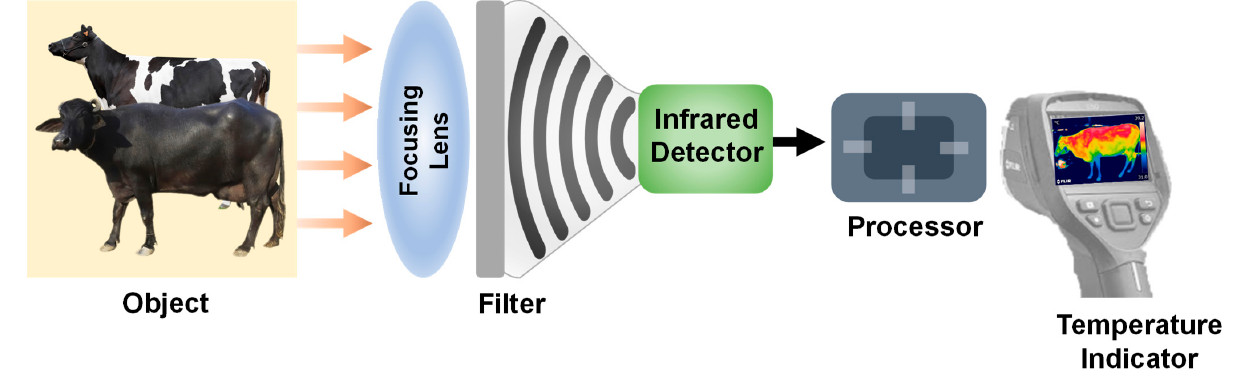
Figure 2. Illustrative diagram of the working principle of an infrared thermographic camera .